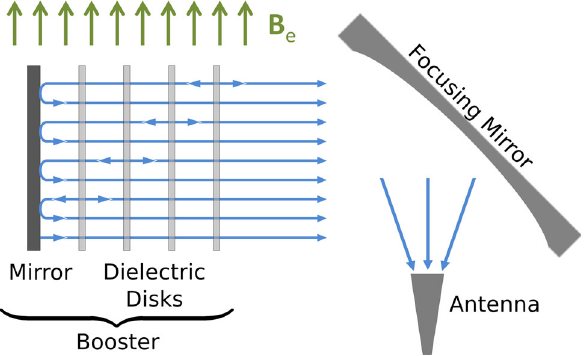
Fig. 1 Conceptual sketch of a dielectric haloscope. In a system of a mirror and multiple dielectric disks (booster) under a strong magnetic field B e each surface emits a coherent electromagnetic wave sourced by axions. Bringing those into constructive interference and making use of weak resonances in the system (not shown), the total amplitude can be much enhanced (characterized by the boost factor). The total emitted power can be received by focusing it onto an antenna. Adapted from [33] with